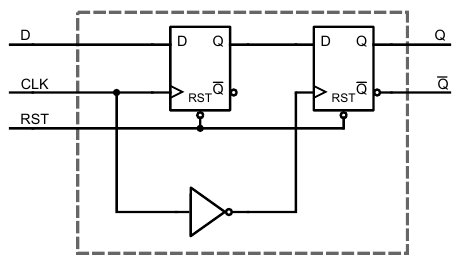
Figure 6. Master–slave D flip-flop.